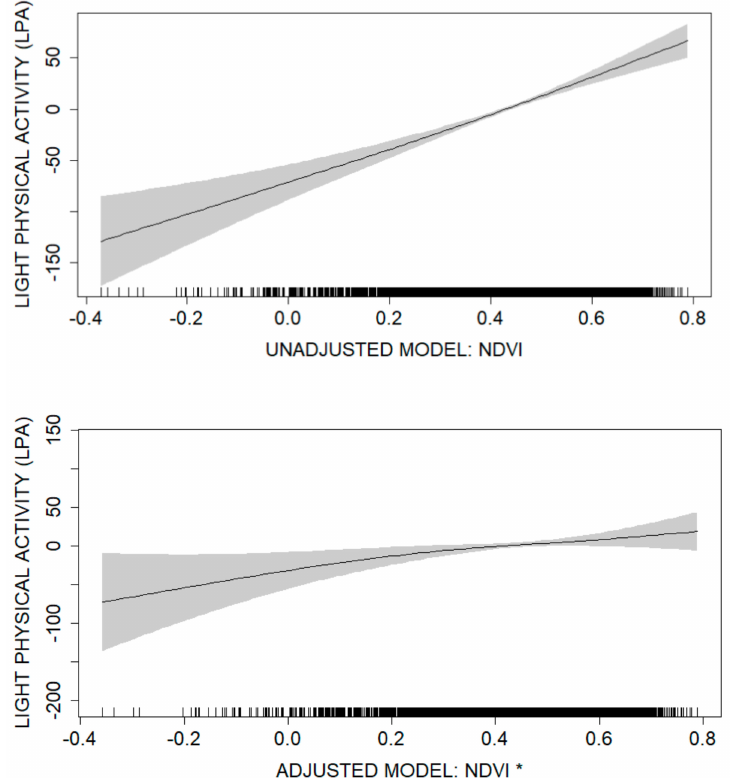
Figure 1. The association between residential greenness and the amount of light-intensity activity in the crude model and in the adjusted model. Values close to − 1 indicate water bodies, rock, and snow. Values close to 0 (such as 0.2–0.3), in turn, indicate densely built surfaces or other surfaces with sparse vegetation. Highly positive values ( > 0.6) indicate areas with very dense and healthy green vegetation, such as forests and paddocks [41]. * The model was adjusted with: BMI kg / m 2 , physical strenuousness of work, children < 18 years old in the family, high education, daily alcohol intake (g), excellent / good perceived health and number of sport